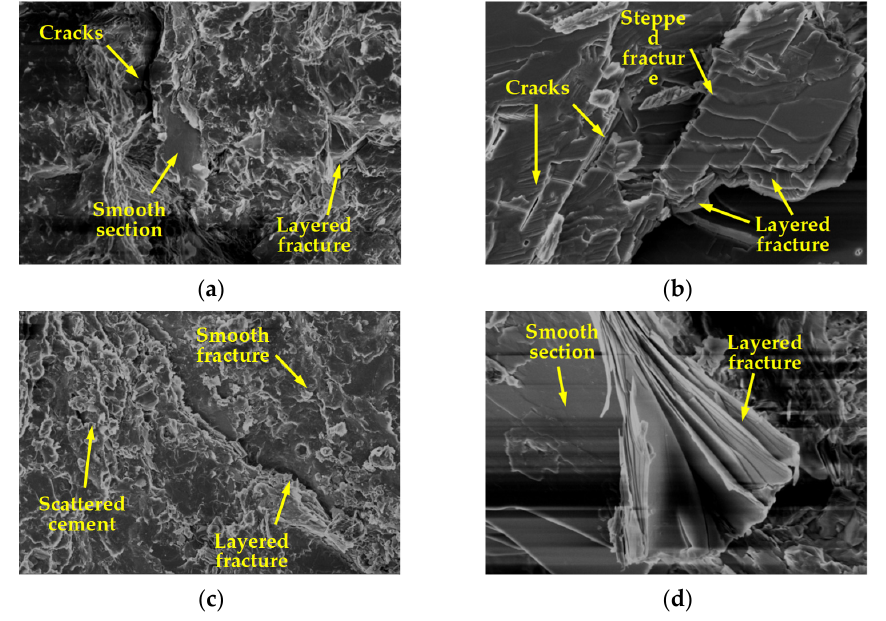
Figure 14. Micro-cracks and fracture characteristics under parallel loading: ( a ) Gray sample (2000×); ( b ) Gray sample (5000×); ( c ) Carbonaceous sample (2000×); ( d ) Carbonaceous sample (5000×). The fracture morphology and micro-fracture characteristics of slate samples indicate that slate microstructure has three types of microstructure fracture modes; intergranular fractures (cracks appear on the edge of the crystal and cement), transgranular fractures (stress concentration causes cracks to pass through the crystal), and intergranular- transgranular composite fractures (cracks gradually expand through the cement and crystal structure), which is consistent with shale micromechanical features [36–40]. There are differences in fracture smoothness, fracture area, and the presence of micro-cracks between vertical and parallel loading modes. 4. Conclusions The direction of stress loading and the bedding effect significantly impact strain and mechanical parameters. The deformation goes through compaction, elastic, damage accumulation, and failure stages, and there are significant differences in strain paths. The weak structural plane of the bedding controls the overall deformation when loaded perpendicular to a weak surface structure, showing a significant plastic deformation. The rock pillar effect weakens the axial deformation under parallel loading. The mechanical properties of grey and carbonaceous slate have significant discrete features. The variation coefficient of gray slate samples is characterized by the peak stress, expansion stress, and elastic modulus of 1.22, 1.35 and 0.69, respectively. The variation coefficient of the carbonaceous slate samples is characterized by the peak stress, expansion stress, and elastic modulus of 1.46, 1.38, and 0.71, respectively. The uniaxial compression